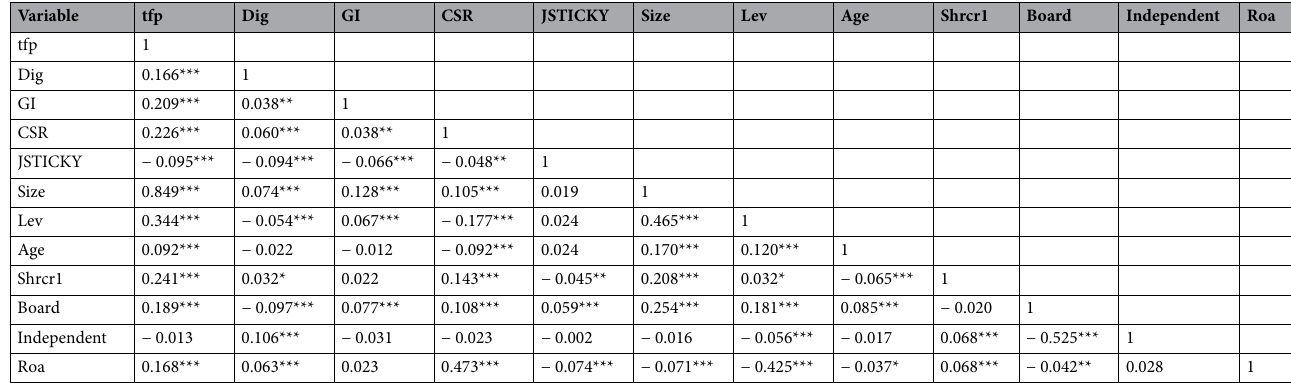
Table 3. Correlation analysis. T-statistics are shown in parentheses. ***, ** and * indicate 1%, 5% and 10% respectively.